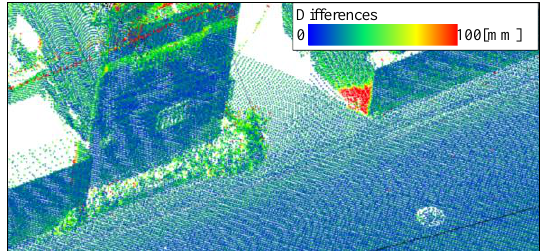
Figure 9. Detailed differences at position C